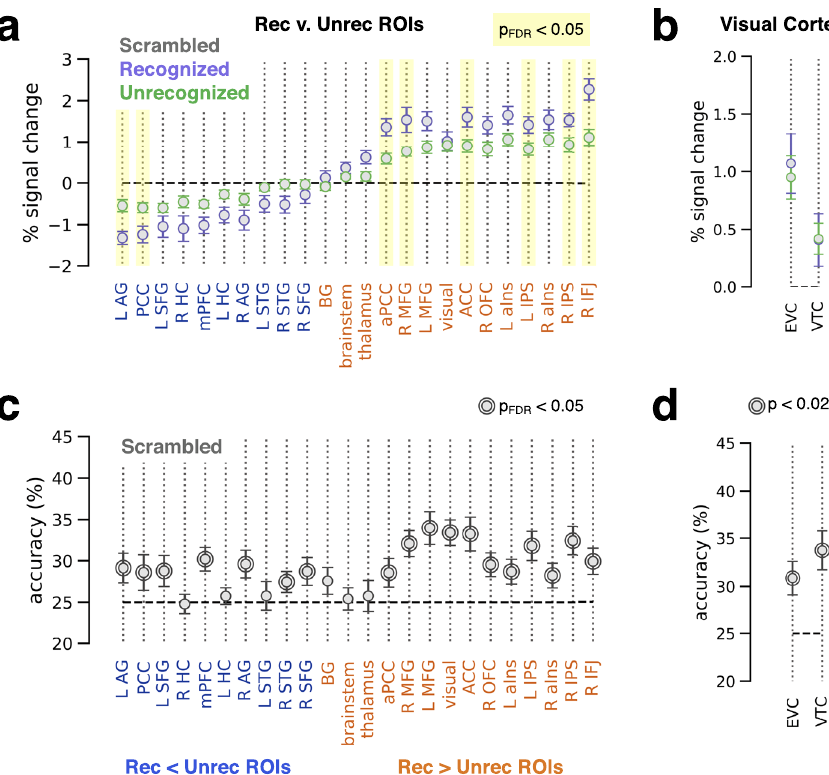
Fig. 7 Neural responses and category information elicited by phase-scrambled images. a GLM-estimated percent signal change of stimulus-triggered response for each ROI de fi ned in Fig. 3. Data are separated by subjective recognition report, averaged across stimulus categories. Shaded columns: signi fi cant difference between recognized and unrecognized, paired t -test, p < 0.05, FDR-corrected across ROIs ( N = 25). b Same as a , but for individually- de fi ned early (EVC, N = ;23) and category-selective (VTC, N = 25) visual areas. c, d Stimulus category decoding accuracy within recognition-contrast ROIs ( c , same ROIs as in a , N = 25) and individually-de fi ned visual ROIs ( d , N = 23). Rings around data points: signi fi cant difference from chance, one-sided label permutation test, p < 0.05 FDR-corrected across ROIs ( c ) or p < 0.025 ( d ). In all plots, error bars indicate s.e.m. across